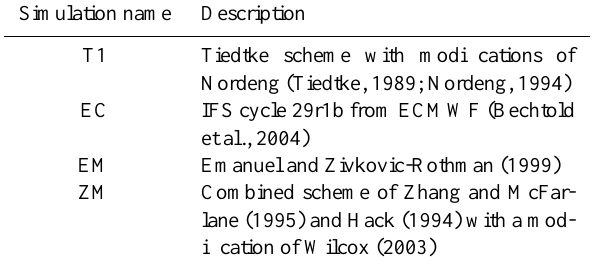
Table 1. Convection parameterisations applied in the individ- ual simulations; to differentiate between the reference simulation, 2 × CO 2 simulation and the two resolutions the following abbrevia- tions are added to the simulation name: REF or 2 × CO2 and T42 or